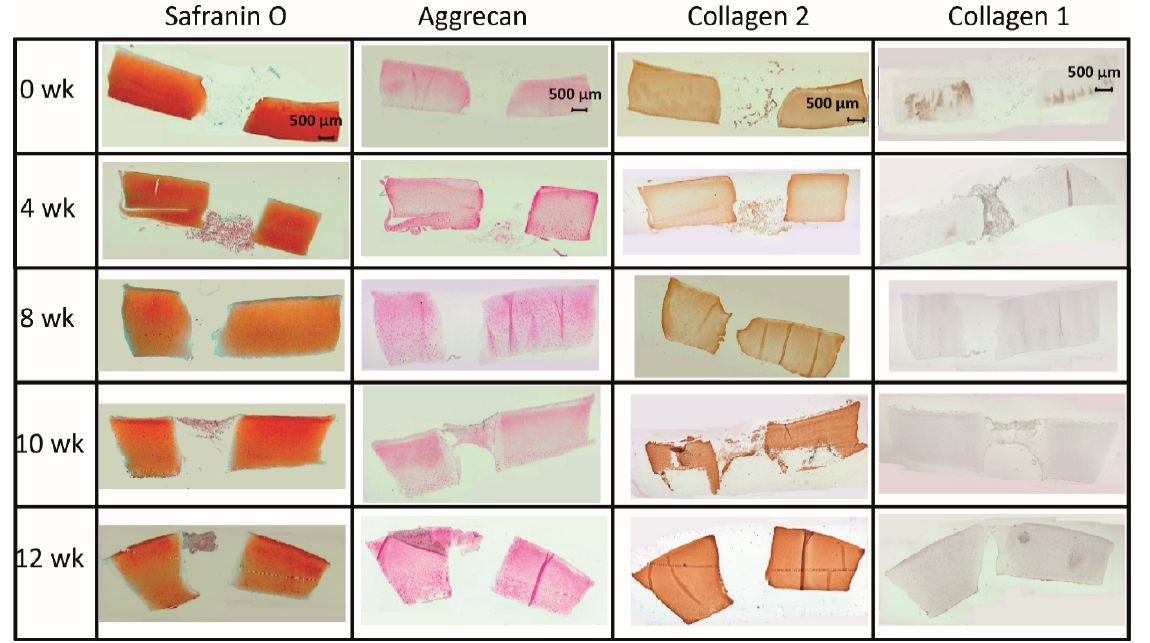
Figure 5. (Immuno)staining of PGA (cell-loaded) during in vitro culture.